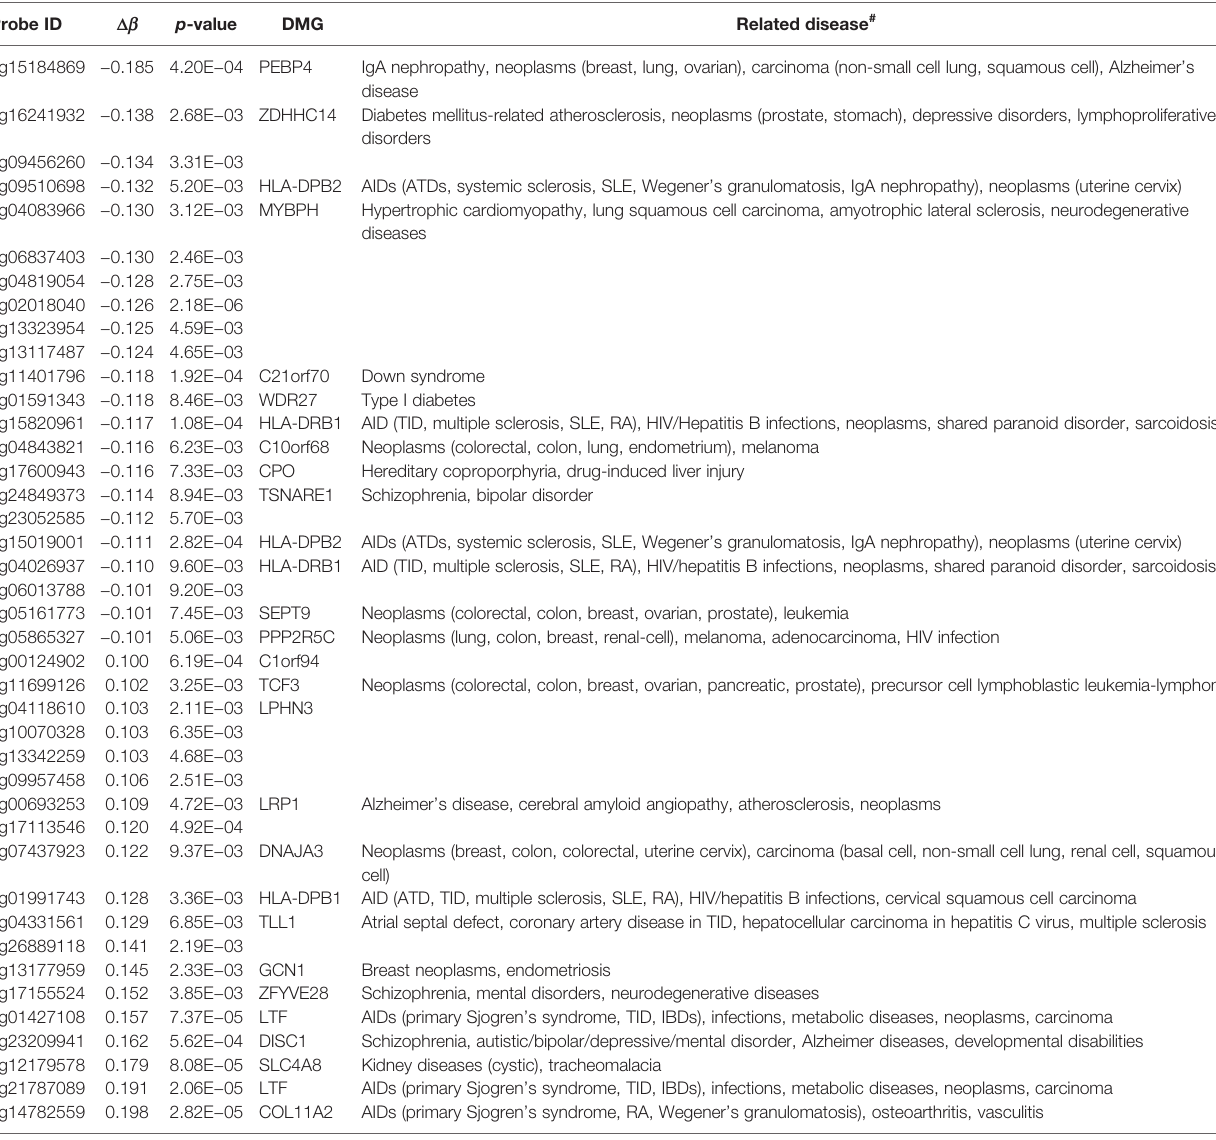
TABLE 3 | The 41 differentially methylated positions ( p < 0.01 and | D b | ≥ 0.1) between the CSU patients and the healthy controls. Probe